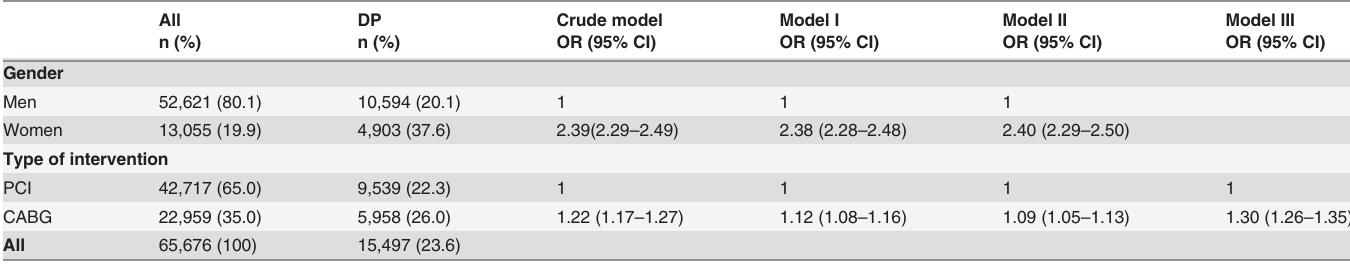
Table 3. Disability pension (DP) at the time of fi rst coronary artery bypass graft surgery (CABG) or percutaneous coronary intervention (PCI), frequencies (n), proportions (%), crude and adjusted odds ratio (OR) with 95% con fi dence intervals (CI), by gender and type of intervention.